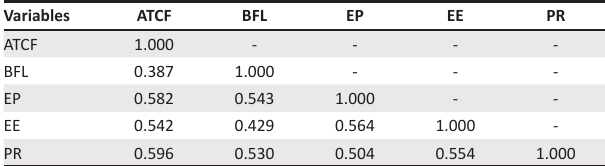
TABLE 2: Results of discriminant validity